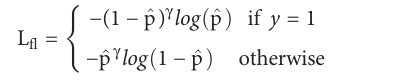
TABLE 2 Network training